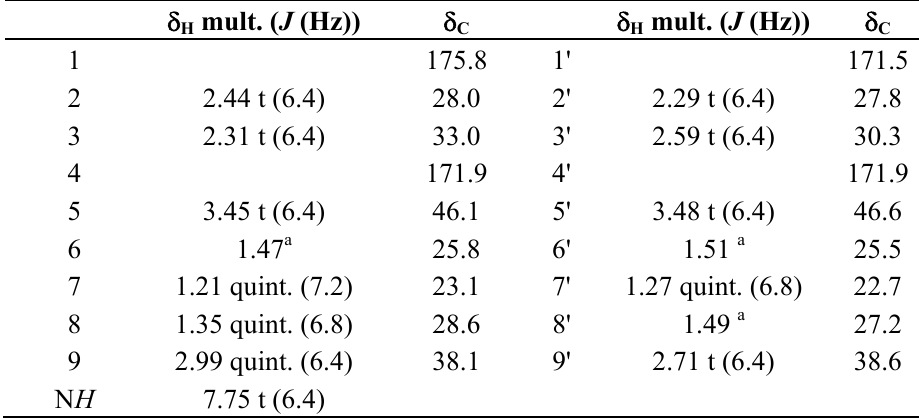
Table 1. 1 H- and 13 C-NMR data for compound 1 in CD